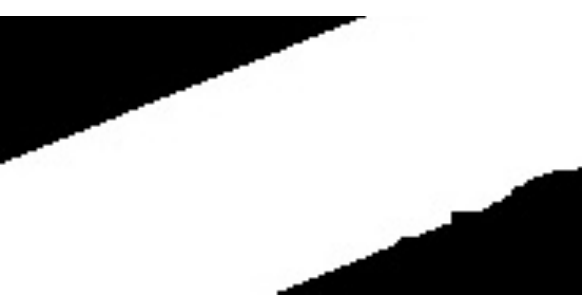
Figure 8: Result of morphological closing